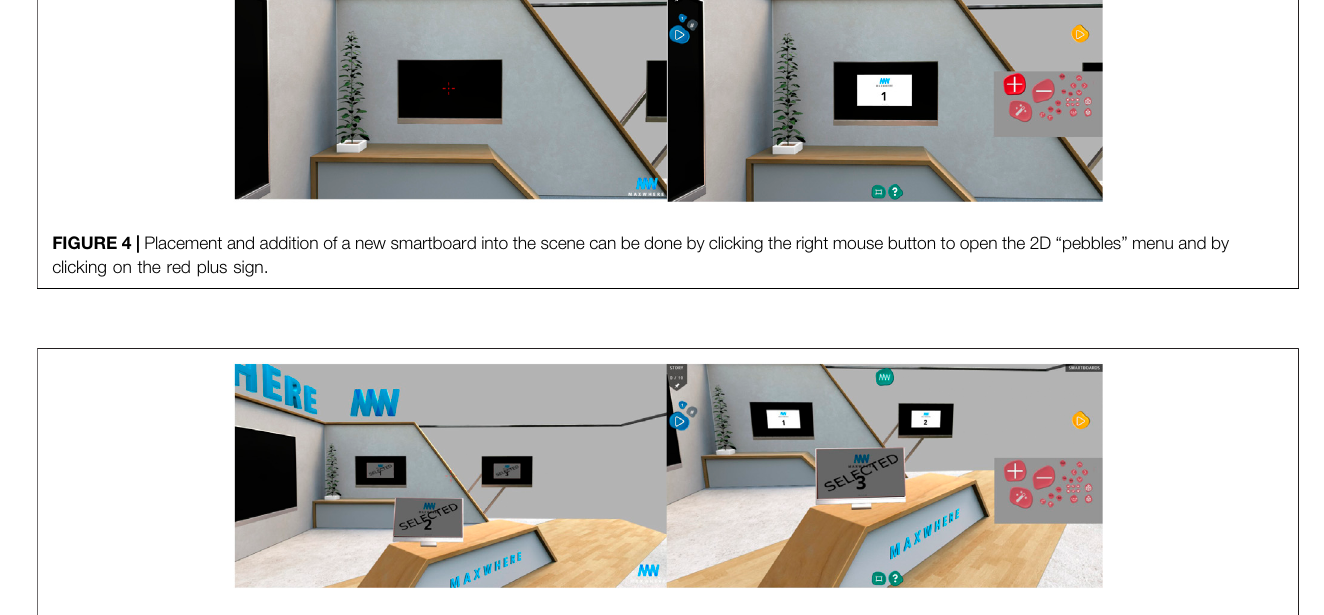
FIGURE5| Smartboardselectionisperformedby fi rsttogglingtheselectionmode(byclickingthemagicwandamongtheredpebbles)andbyhoveringthemouse over the given smartboards in 3D navigation mode.